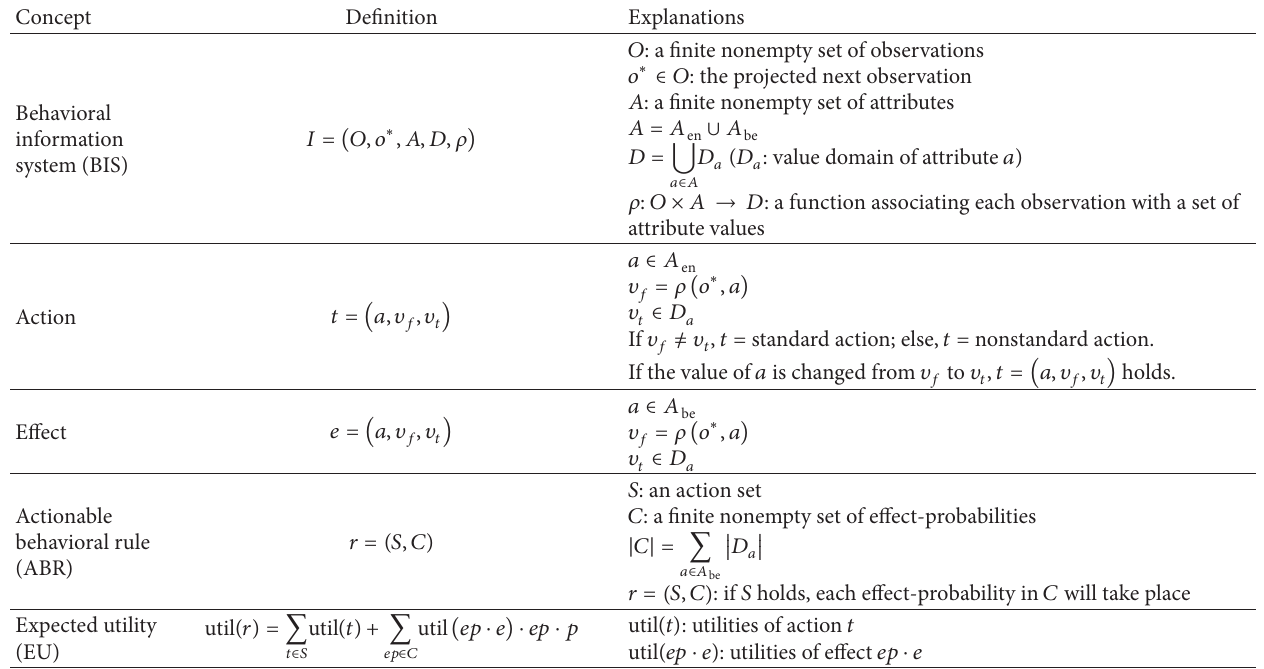
Table 1: Concepts and definitions.